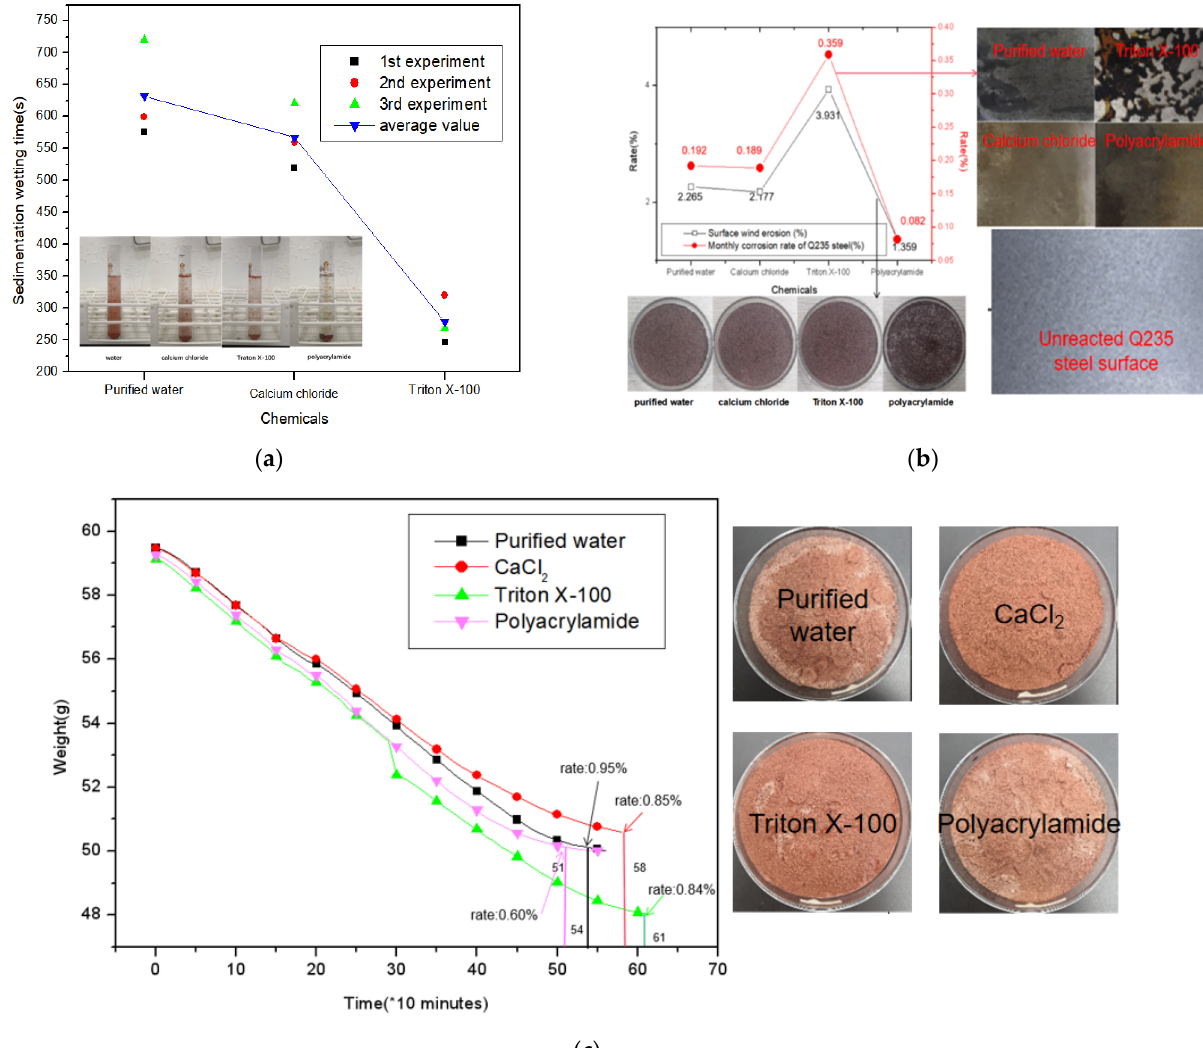
Figure 7. Process diagram of evaluation parameter measurement experiment. ( a ) Distribution map of experimental data for sedimentation wetting time measurement; ( b , c ) Evaporation stabilization time measurement experimental phenomenon and the trend graph of the data changing with time. Table 2. Table of valuation parameter weight coefficients.